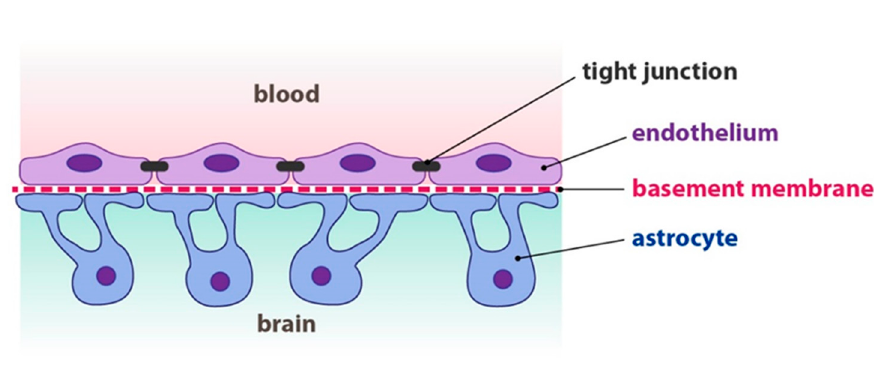
Figure 2. Structure of the blood-brain barrier. Source: Fontana 2013. Reproduced with permission of Josef Fontana.